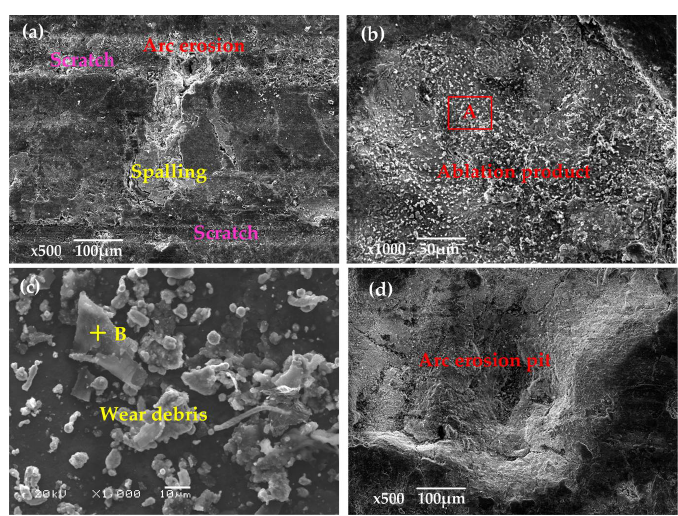
Figure 11. SEM of the worn surfaces at low arcing rate (40 km·h −1 , 40 s, 120 A): ( a ) B = 8 N, f = 0.169 Hz, arcing rate = 0.079%; ( b ) ablation products from ( a ); ( c ) debris from ( a ); ( d ) B = 41 N, f = 0.169 Hz, arcing rate = 2.9%.